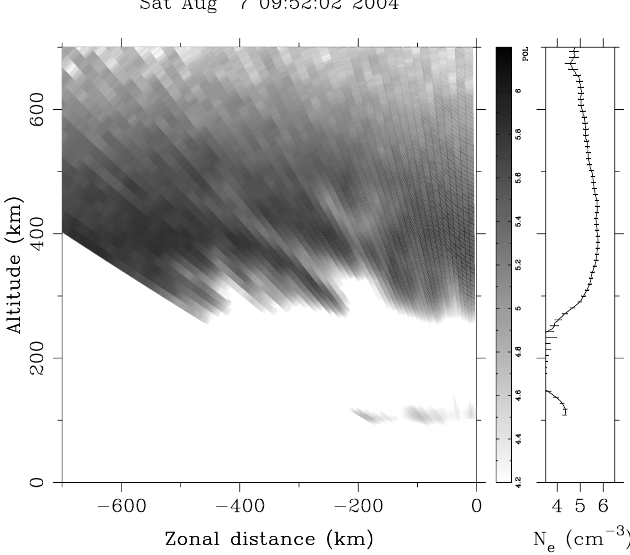
Fig. 9. Altair radar oblique scan for 7 August 2004, 09:52 UT.